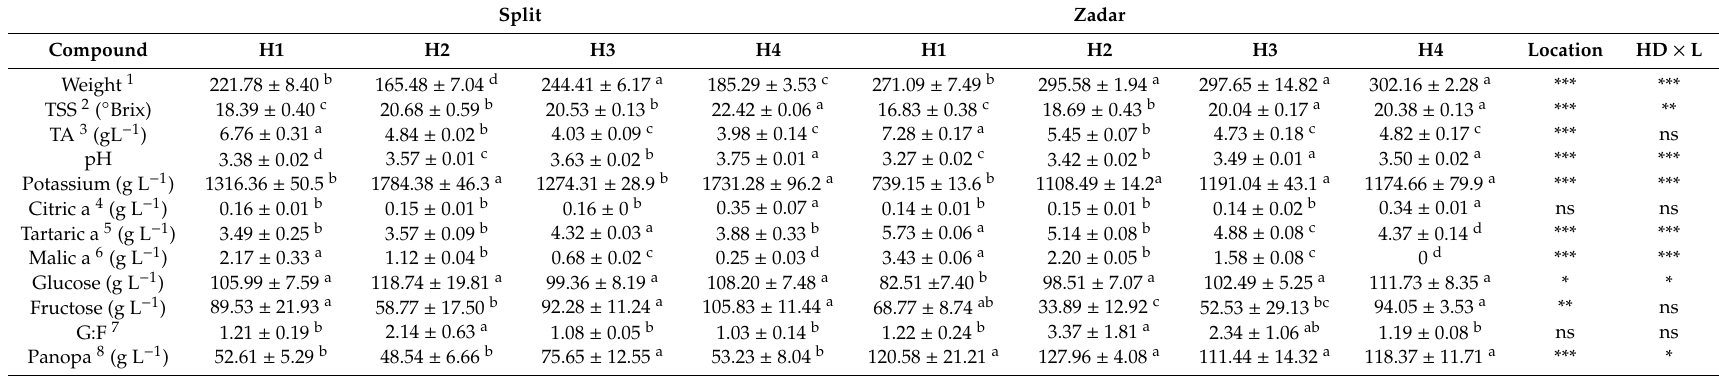
Table 1. E ff ect of the harvest date and growing locations on technological maturity indicators—composition analysis of cv. Plavac Mali grape